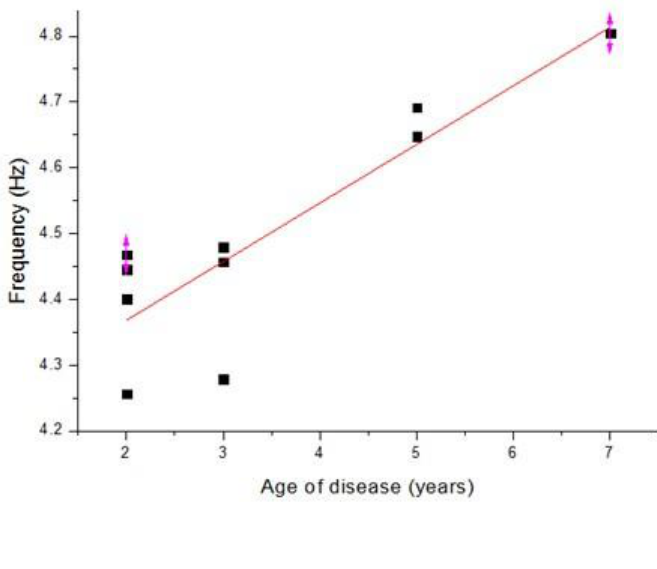
Figure 14. Frequency vibration of the Parkinson’s disease patient’s dorsum manus measured in a resting state after